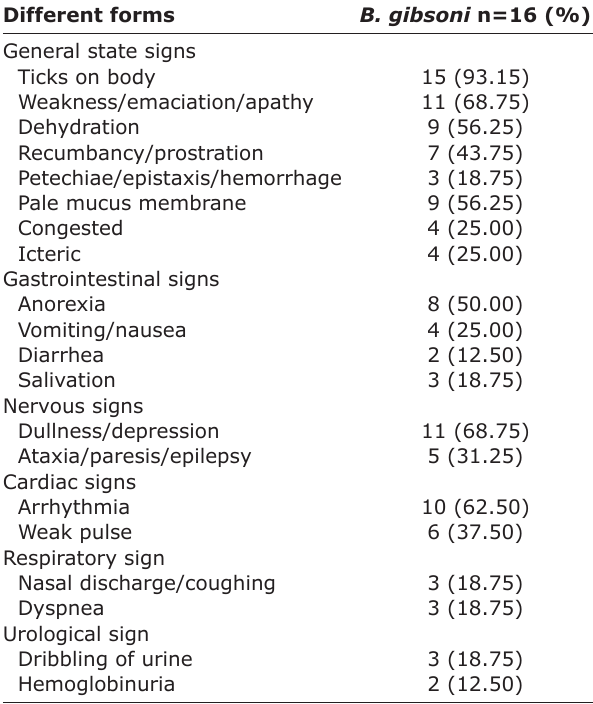
Table-2: Clinical signs in dogs with babesiosis. Different